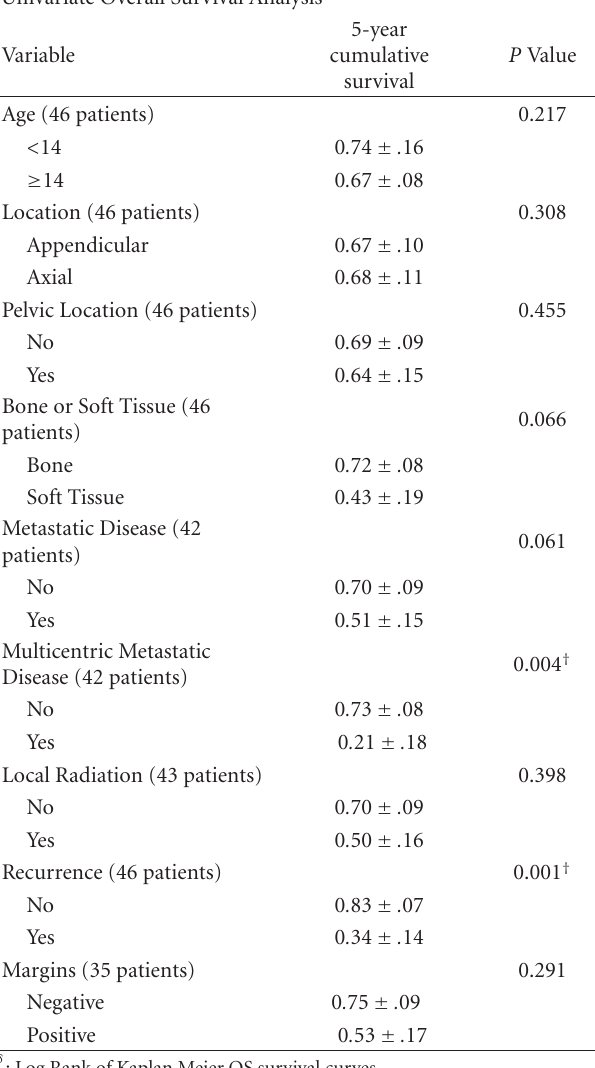
Table 8: Univariate analyses of variables for Overall Survival (OS). Univariate Overall Survival Analysis δ